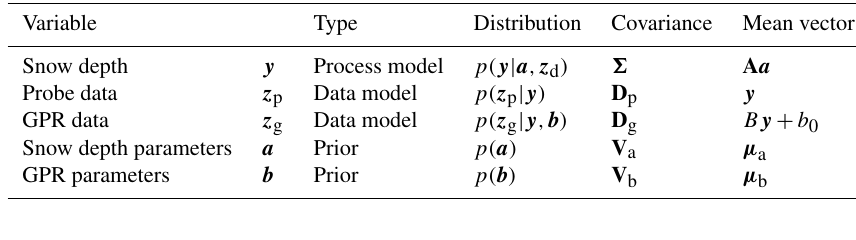
Table 1. Multivariate normal distribution defined for each variable.